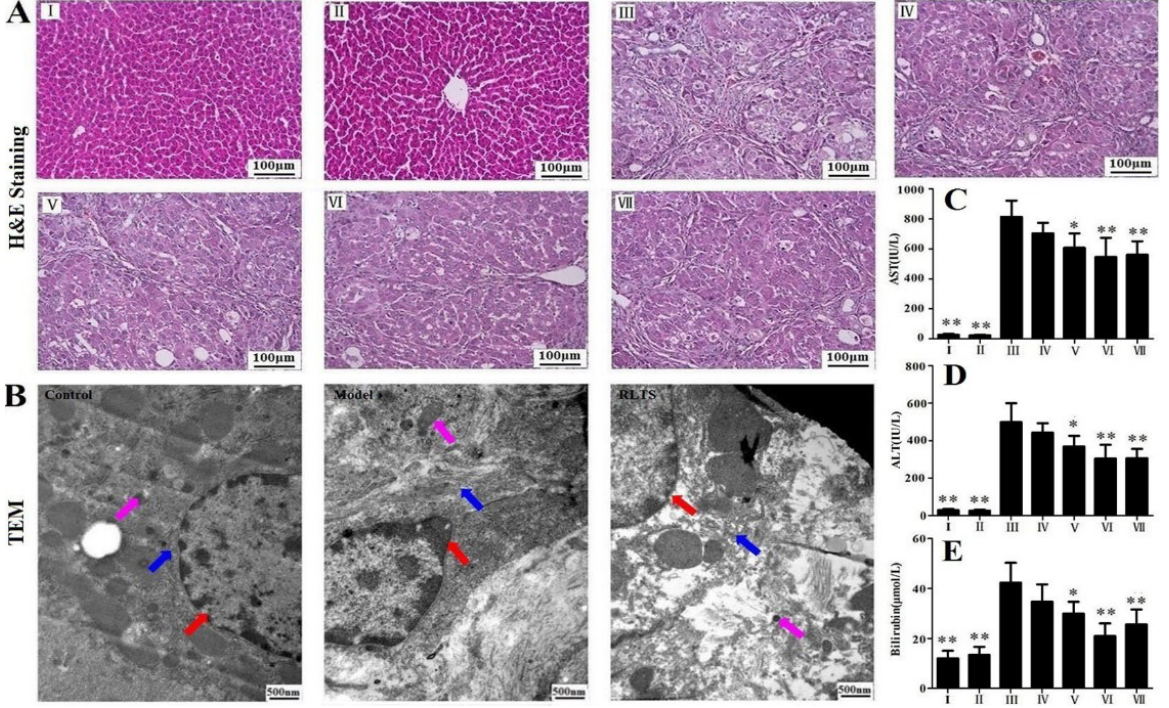
Figure 1. Effects of Rosa laevigata Michx fruit (RLTS) on histopathological examination based on H&E staining ( A ); Effect of RLTS against CCl 4 -induced liver fibrosis based on transmission electron microscopy (TEM) assay (magnification, 25,000×). The red, blue and pink arrows indicate nuclei, endoplasmic reticulum and mitochondria, respectively ( B ); Effects of RLTS on serum ALT, AST activities and the bilirubin content ( C – E ). ( I ) RLTS control; ( II ) Normal control; ( III ) model; ( IV ) RLTS (70 mg/kg) + CCl 4 ; ( V ) RLTS (140 mg/kg) + CCl 4 ; ( VI ) RLTS (210 mg/kg) + CCl 4 ; ( VII ) silymarin (210 mg/kg) + CCl 4 . Values are expressed as mean ± SD ( n = 10). * p < 0.05; ** p < 0.01 vs. model